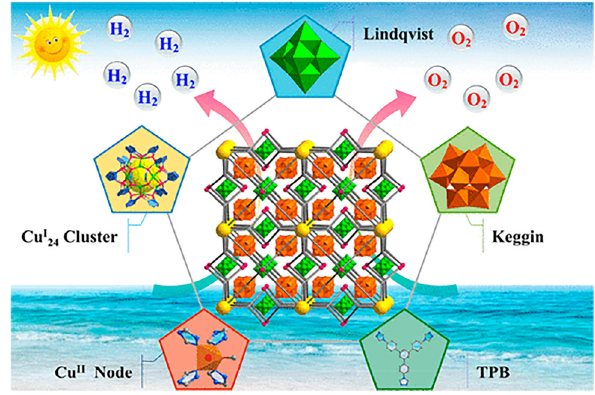
Figure 12: Bifunctional photocatalytic system in which the POM act as oxidizing component and MOF as reductive component facilitatingOERandHERrespectively.Adoptedwithpermissionfrom ref.